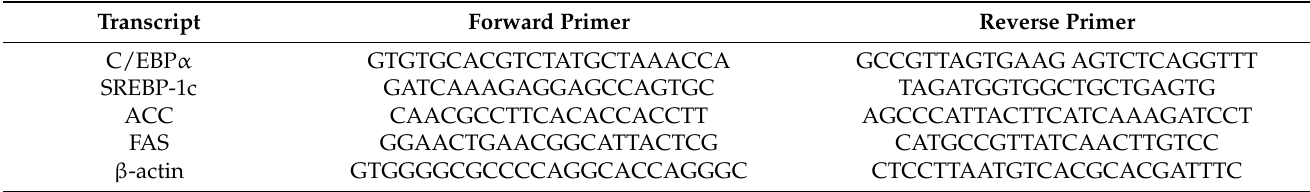
Table 2. Real-Time Polymerase Chain Reaction (RT-PCR) primer sequences for quantitative real-time (5 (cid:48) to 3 (cid:48)